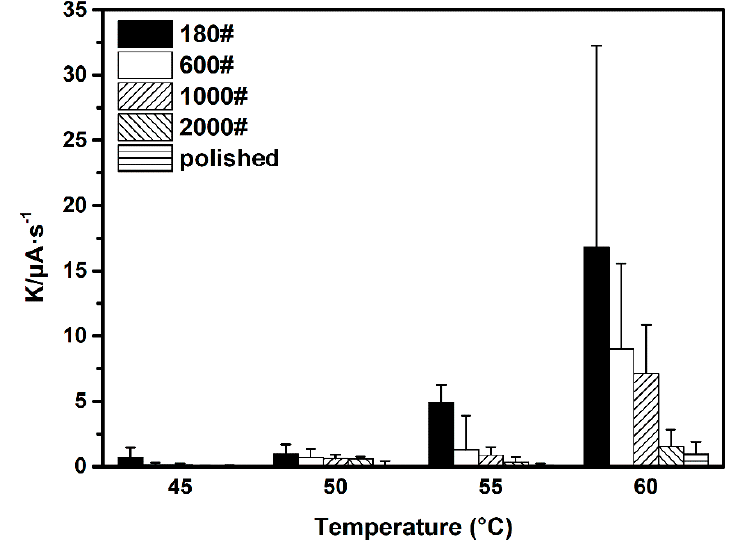
Figure 13. Metastable pit growth rate of different surface roughness DSS 2205 specimens at four testing temperatures.